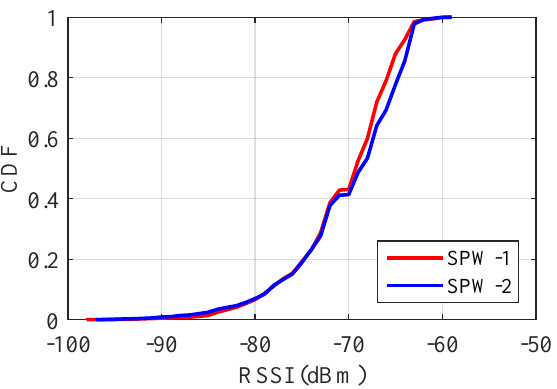
Figure 13. Comparison of the wireless performance of SPW-1 and SPW-2 in the anechoic